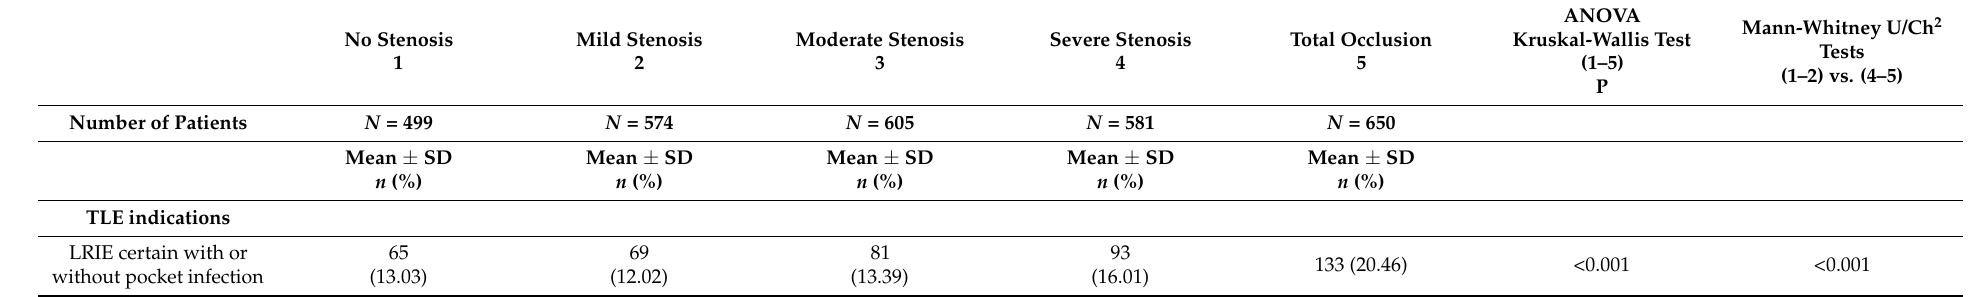
Table 2. Potential indication-related, system-related and history of pacing-related risk factors for lead-related venous